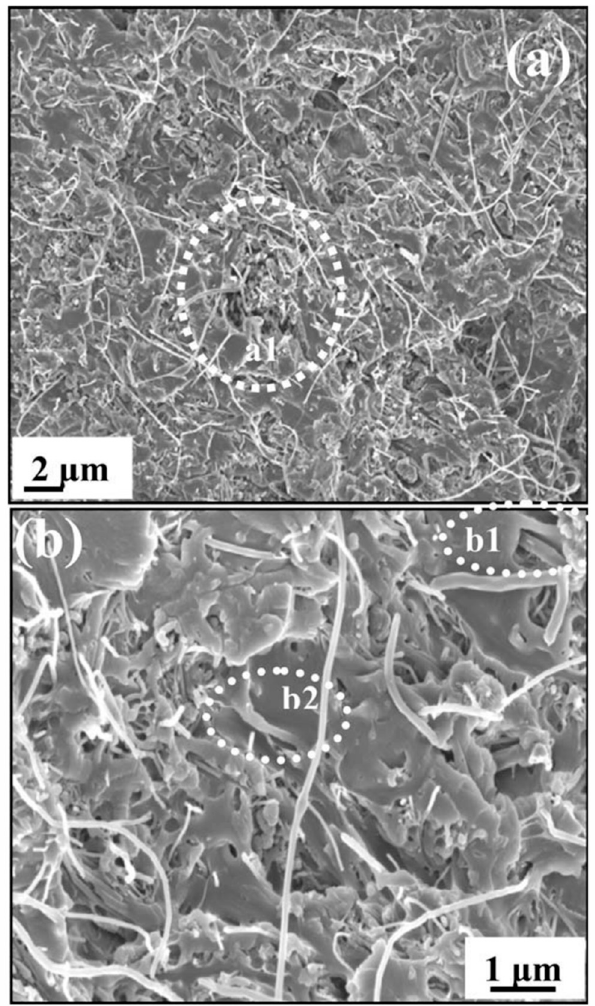
Figure 6. Tensile fractured field-emission scanning electron microscope (FESEM) image of PSU/carbon nanofiber (CNF) nanocomposites ( a ) 5 wt.% CNFs and ( b ) magnified image of ( a ). (Reproduced with permission after [38]).